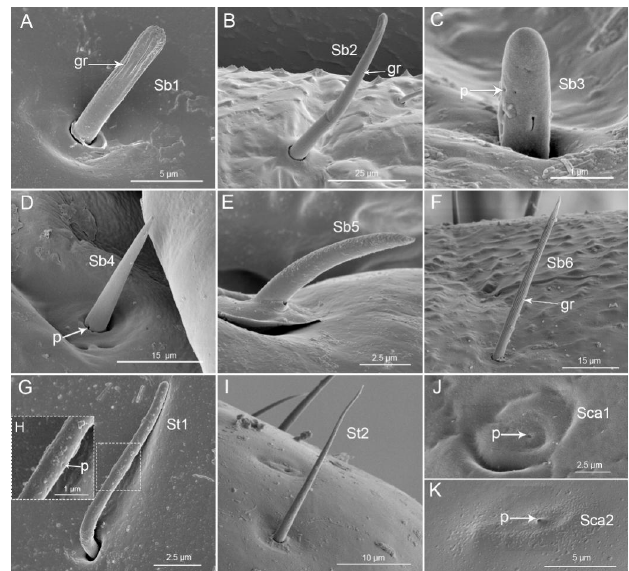
Figure 5. SEM images of sensilla of three species. ( A ) Sensilla basiconica I (Sb1); ( B ) Sensilla basiconica II (Sb2); ( C ) Sensilla basiconica III (Sb3); ( D ) Sensilla basiconica IV (Sb4); ( E ) Sensilla basiconica V (Sb5); ( F ) Sensilla basiconica VI (Sb6); ( G ) Sensilla trichodea I (St1); ( H ) Enlarged view of sensilla trichodea I (St1); ( I ) Sensilla trichodea II (St2); ( J ) Sensilla campaniformia I (Sca1); ( K ) Sensilla campaniformia II (Sca2); gr, groove; p, pore.